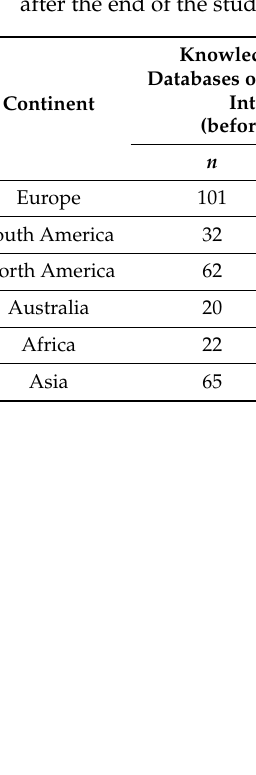
Table 4. Psychiatrists’ knowledge of the pharmacological interaction databases before their use in the study, interest in them after the end of the study, and opinions that they can be effective in everyday work.